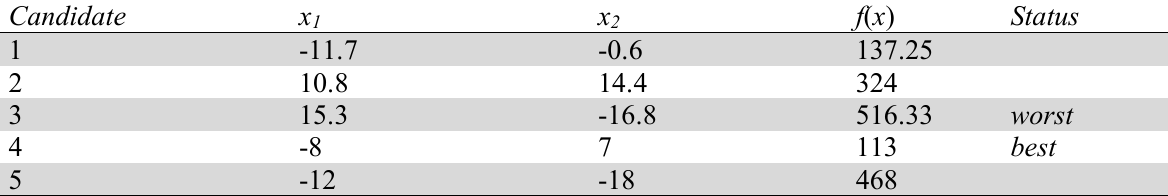
Updated values of the variables and the objective function based on fitness comparison at the end of first iteration (Rao-3)